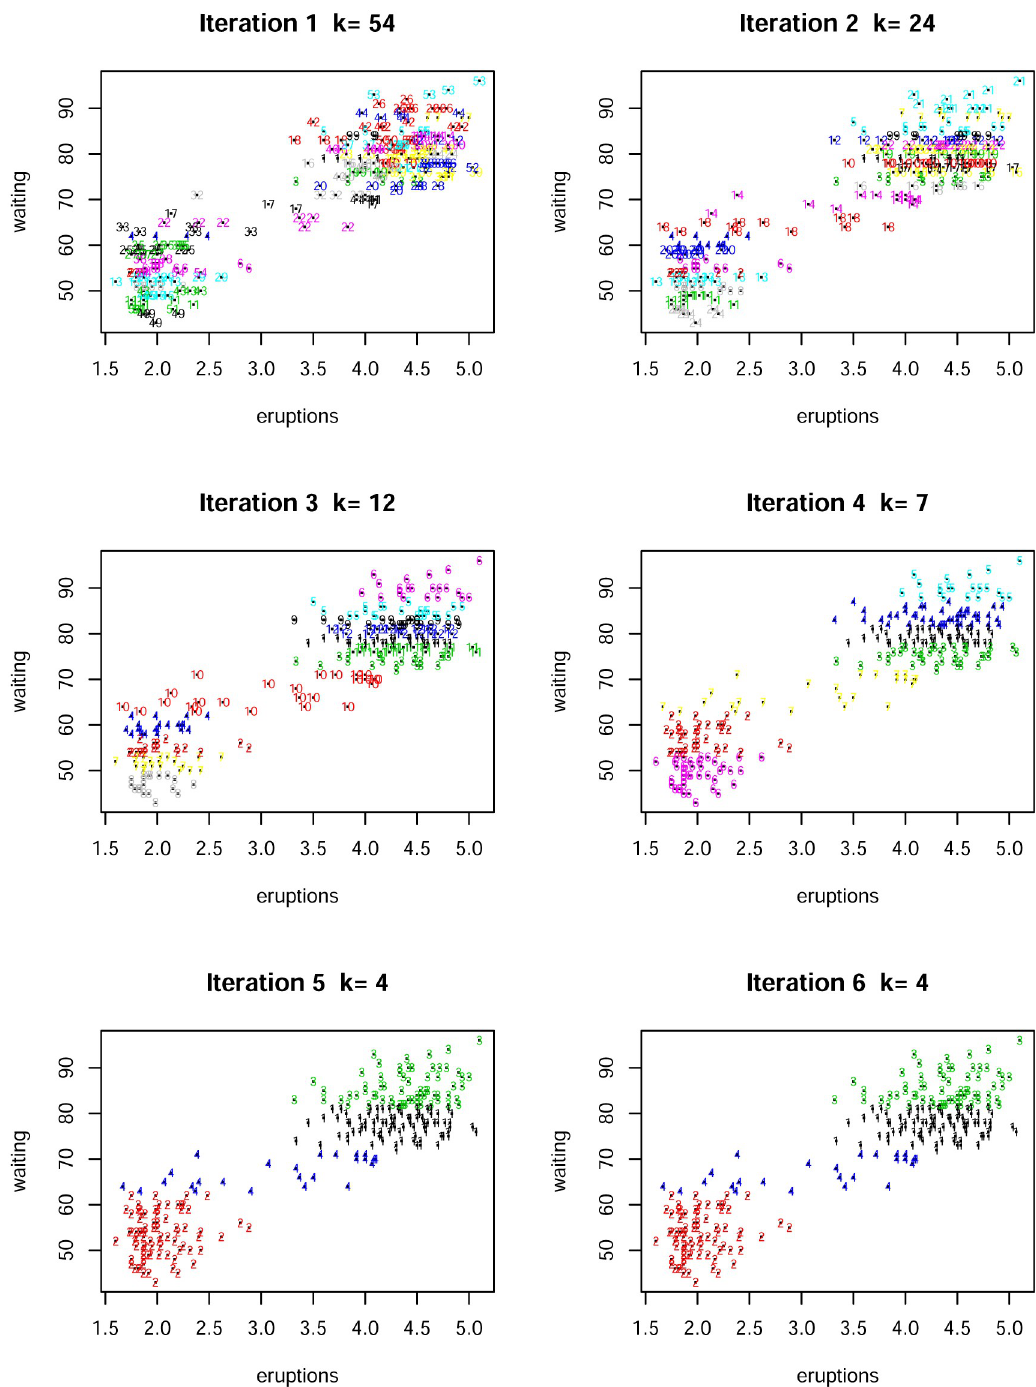
Fig 2. A number of the iterations with current clusters for the Old Faithful data set. The final number of clusters is four.